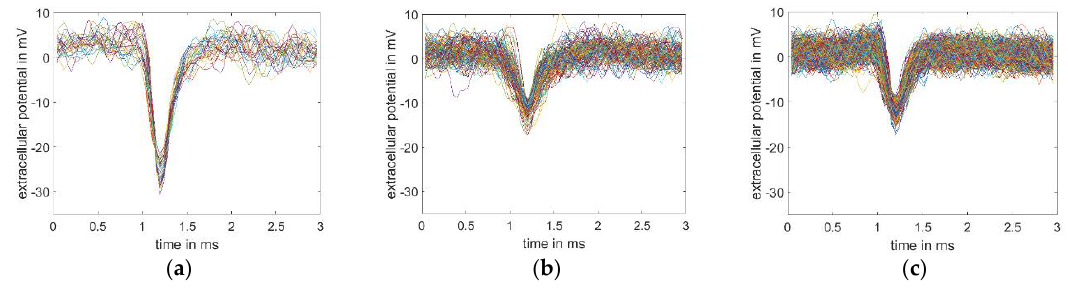
Figure 10. Spike sorting of the spike train of electrode 32 during full field stimulation resulted in two clusters ( a , b ). Holographic single-cell stimulation revealed only a single cluster ( c ).